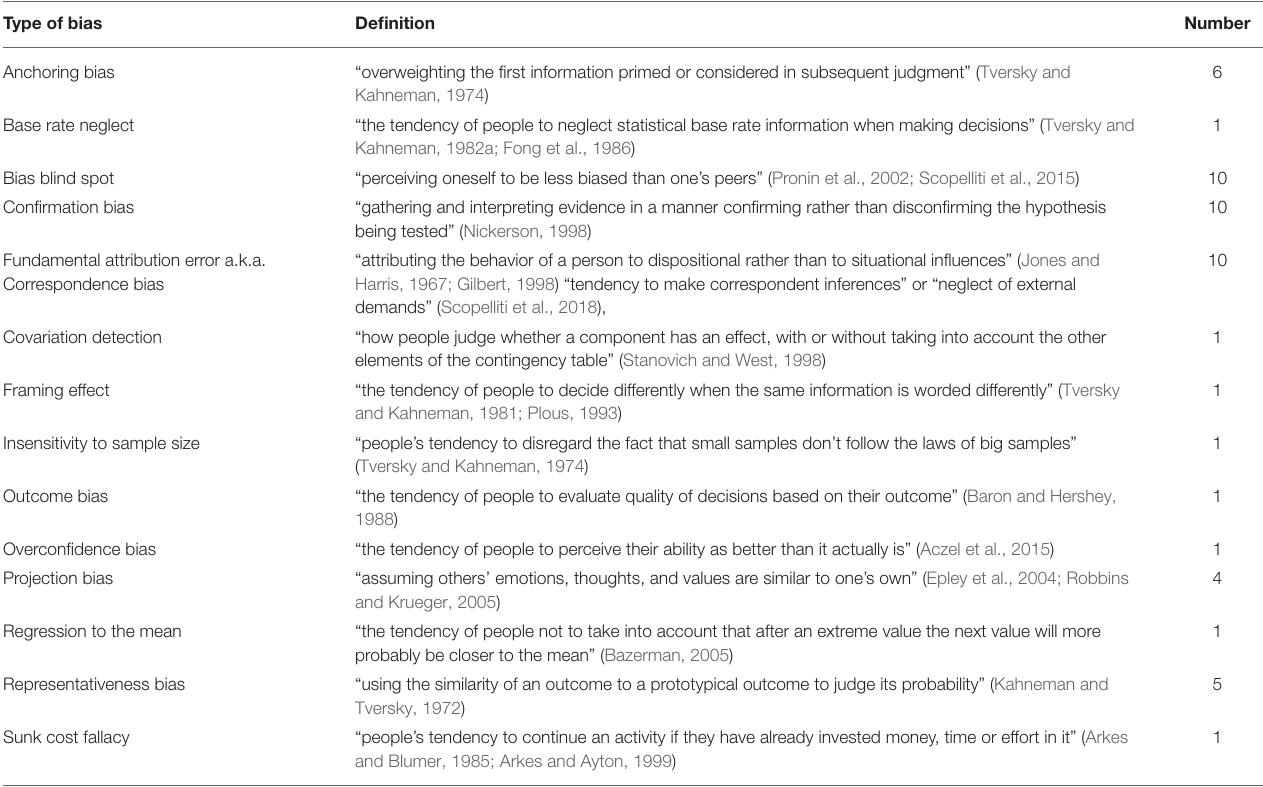
TABLE 1 | Definitions of cognitive biases and number of mitigation experiments in which these biases were